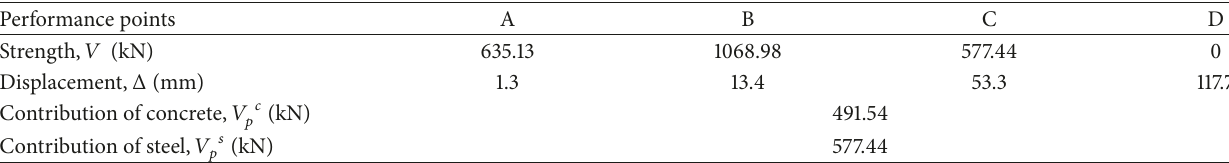
Table 6: Key parameters of the shear